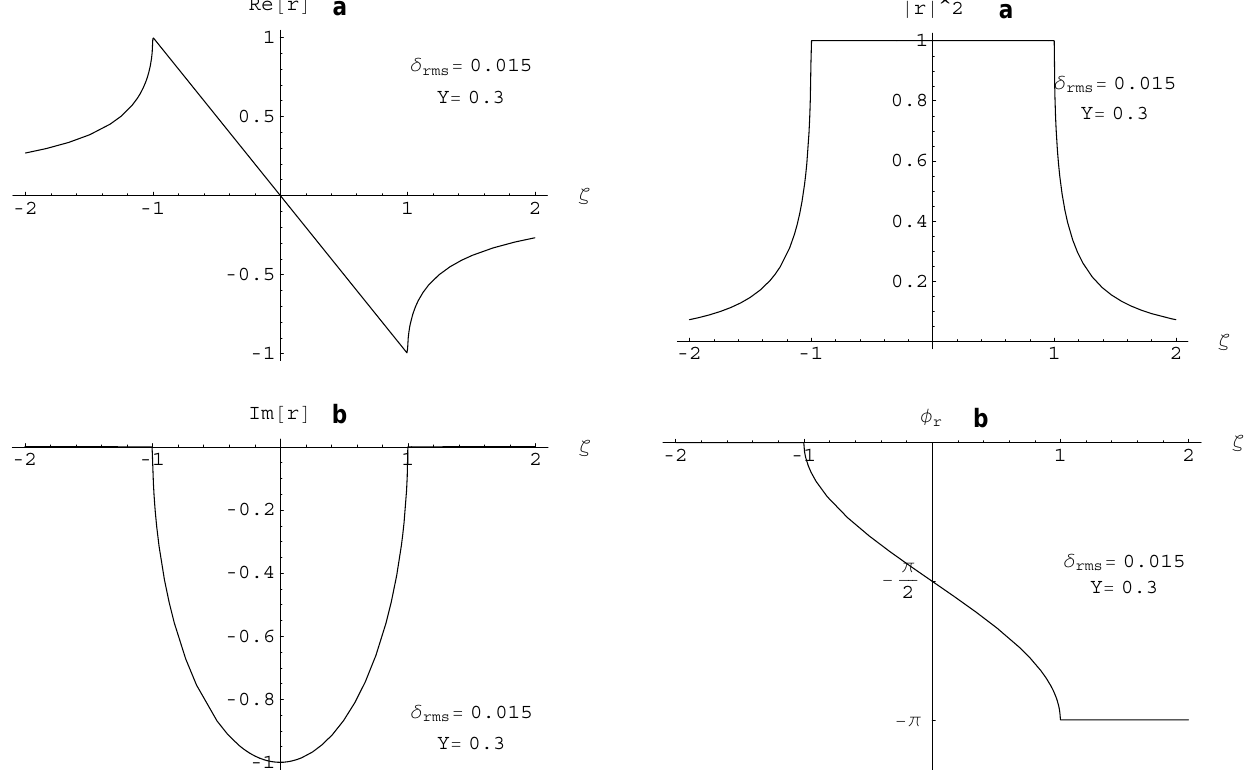
Fig. 1 Fig. 1. The real (a) and imaginary (b) parts of the multiple scatter coupling function, r , as a function of coordinate, ζ .